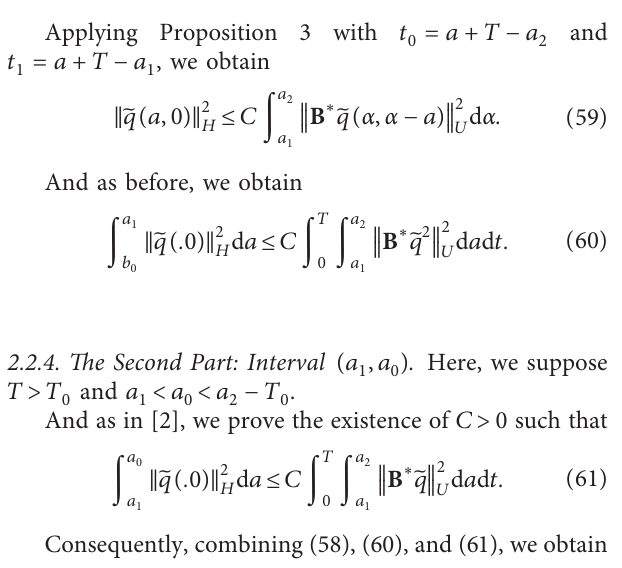
Figure 2: An illustration of the estimate of q ( 0 ,t ) . Here, we have � 􏽢 a . Since t ∈ ( 0 ,T − η ) with a chosen a 2 backward characteristics starting from ( 0 , t ) enters the observation